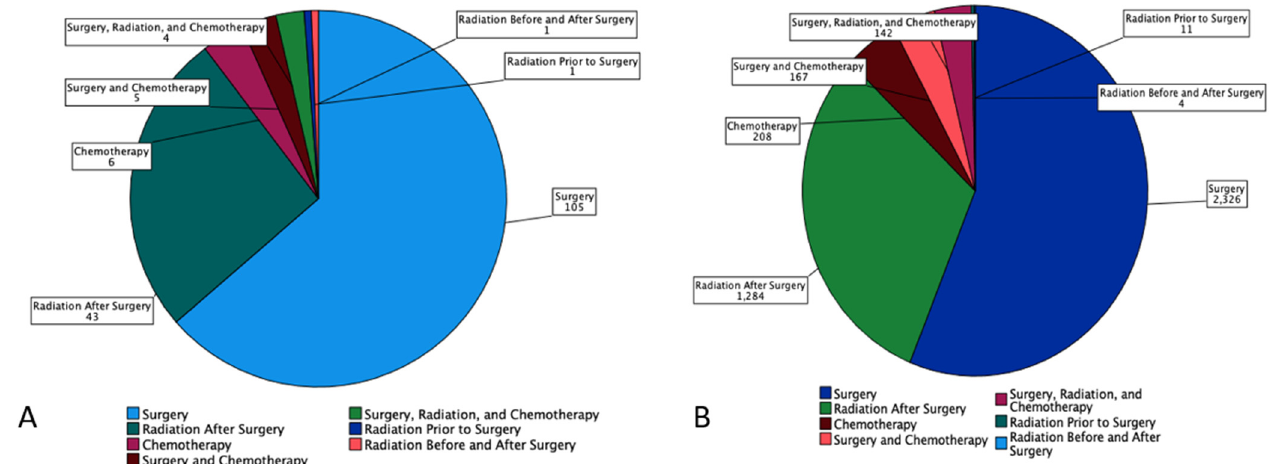
Figure 1. Pie chart based on 4507 Patients with Mucoepidermoid Carcinoma (MEC) from SEER Database (2000–2018). It displays number of patients ( n ) undergoing each treatment modalities (surgery, radiation prior to surgery, radiation before and after surgery, radiation after surgery, chemotherapy, surgery and chemotherapy, and combination of surgery, radiation, and chemotherapy by ( A ) Pediatrics and ( B )